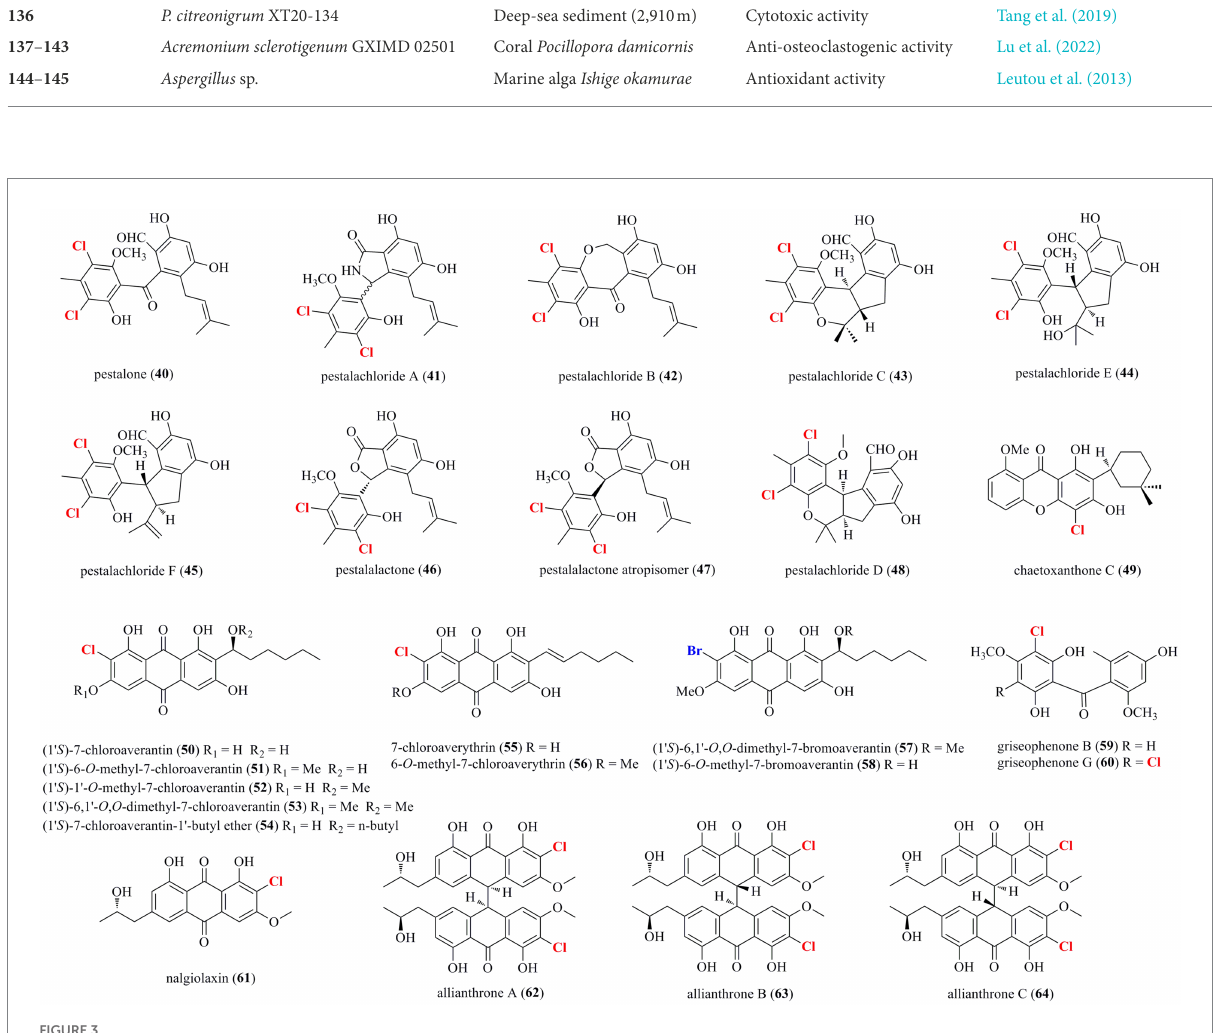
FIGURE 3 Halogenated benzophenones from marine-derived fungi ( 40–64